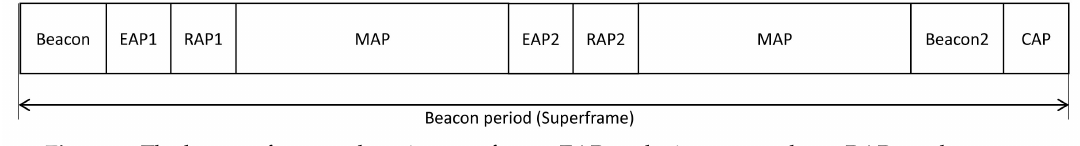
Figure 2. The layout of access phase in superframe. EAP, exclusive access phase; RAP, random access phase; MAP, managed access period; CAP, contention access